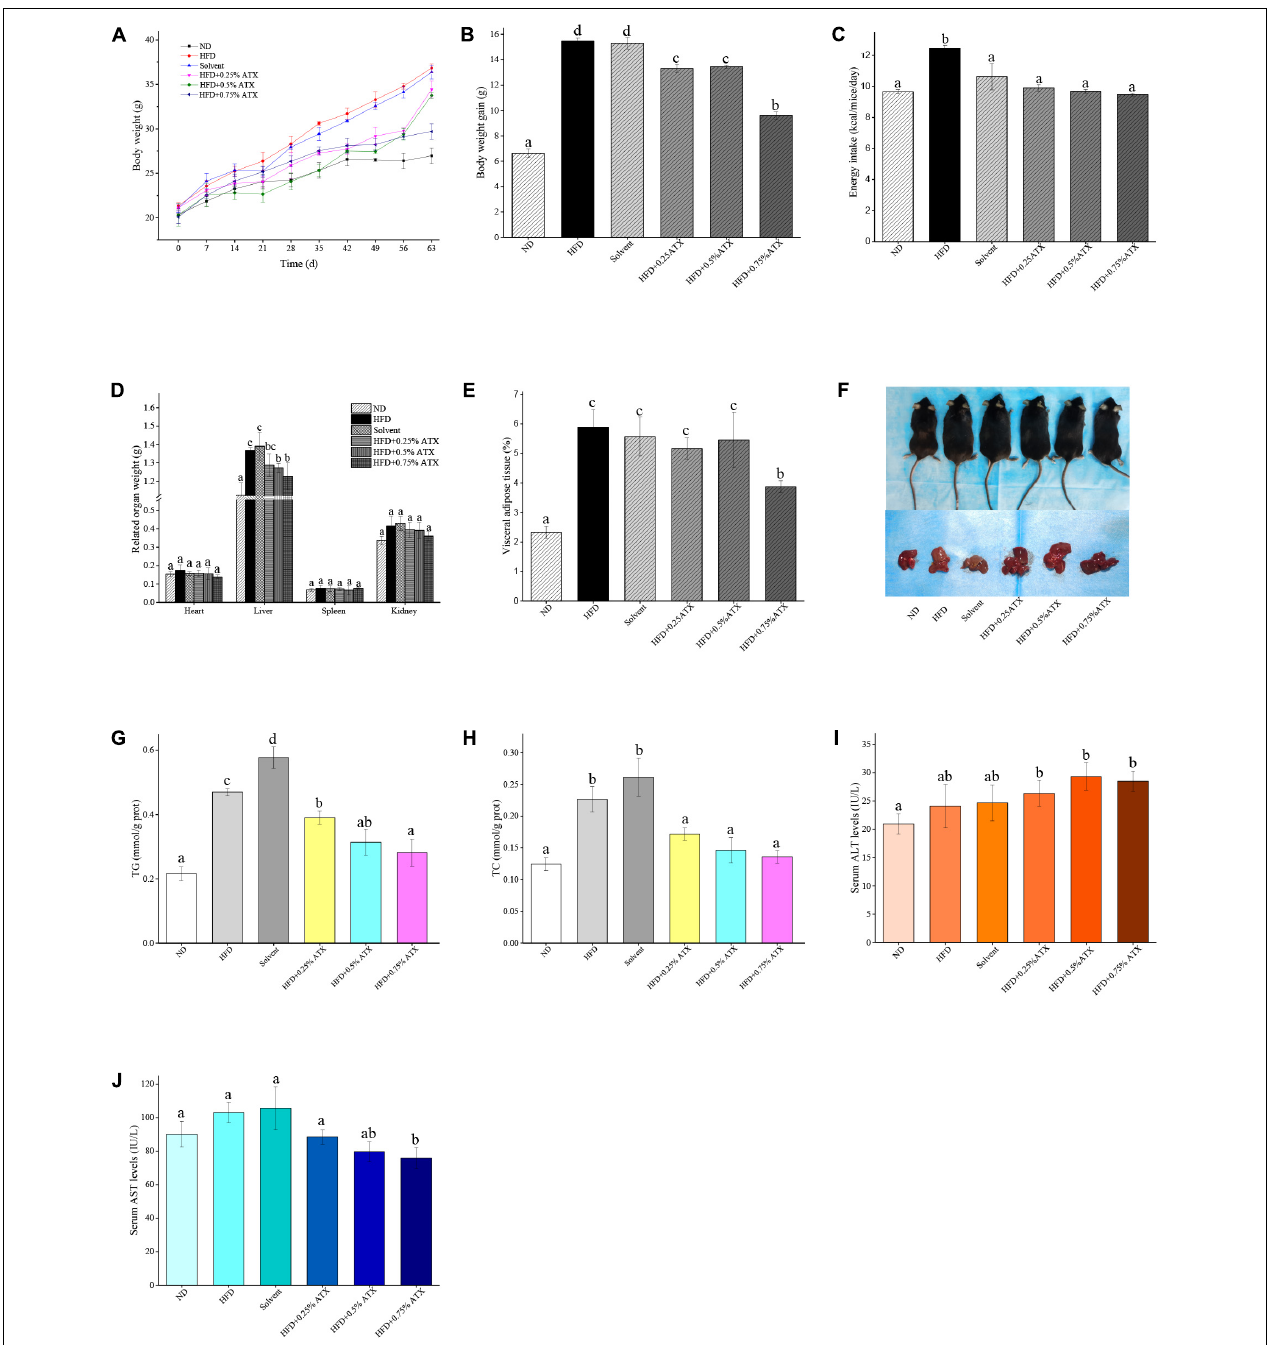
FIGURE 1 | Astaxanthin (ATX) prevented obesity and related indices in HFD-fed mice. (A) Body weight. (B) Body weight gain. (C) Energy intake. (D) Related organ weight. (E) Visceral adipose tissue. (F) Visual appearance pictures of metabolic mice and liver. (G) Hepatic TG level. (H) Hepatic TC level. (I) Serum ALT level. (J) Serum AST level. Values are expressed as mean ± SD of triplicate ( n = 6). The different letters (a–d) indicate significant differences ( P < 0.05) according to Duncan’s multiple range test in ANOVA.